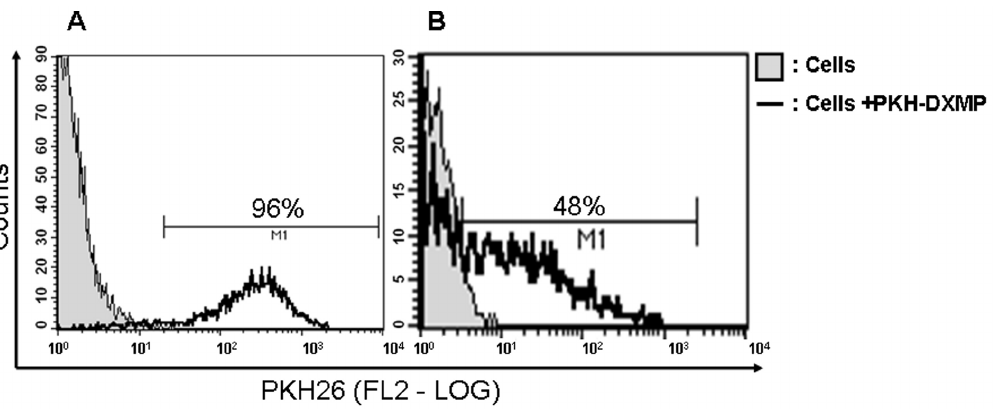
Figure 2. Detection of PKH-26 labeled DxMP binding to normal cells by flow cytometry (FCM). After purification and staining, the co- incubation of PKH-26 DXMP labelled DXMPs ( A ) 96% of the breast epithelial (MBE) cells (black histogram) and ( B ) 48% of the osteoblasts (HO-f) showed PKH26 fluorescence (black histogram) with respect to the cells with no MP incubation (gray histograms). The experiment was repeated at least 2–3 times with similar results. Data are representative of a typical experiment.